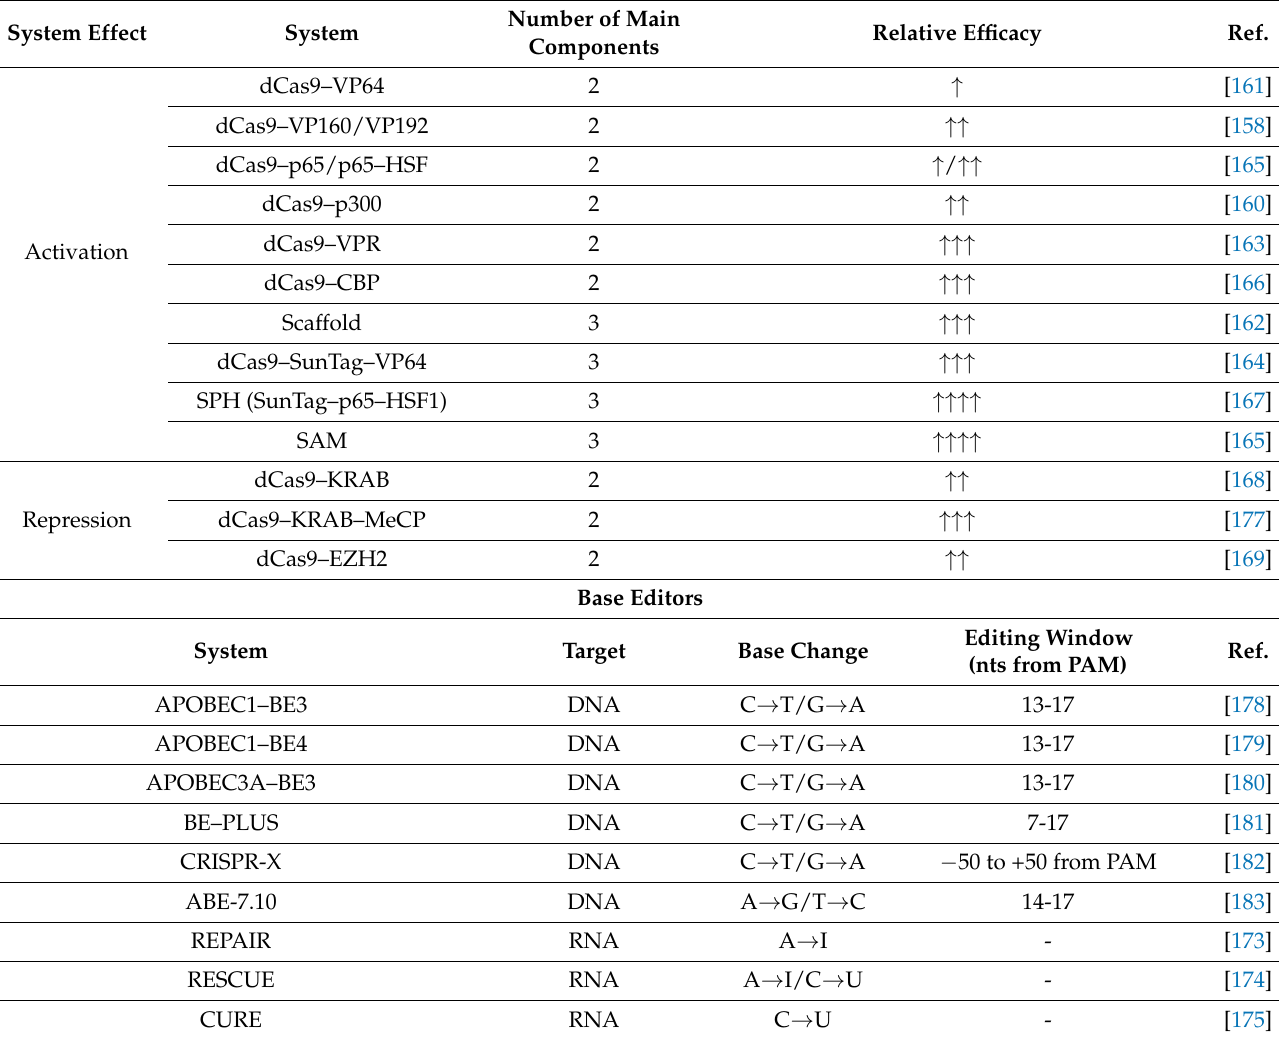
Table 2. Comparison of most common CRISPRa, CRISPRi, and base editing